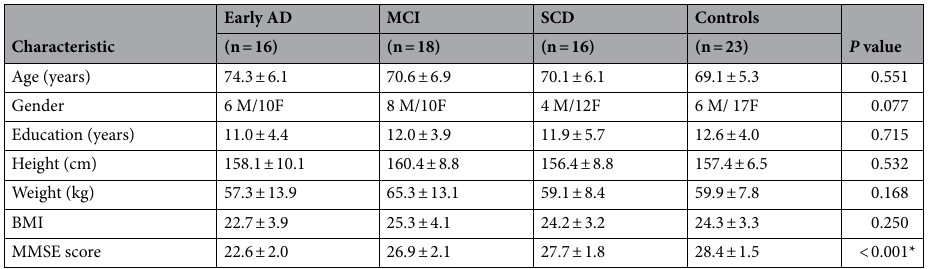
Table 1. Demographics and clinical characteristics of study participants. AD Alzhimer’s disease; MCI mild cognitive impairment; SCD subjective cognitive decline; MMSE mini-mental state examination. *Significance was tested using Mann–Whitney U and chi-square tests of differences between